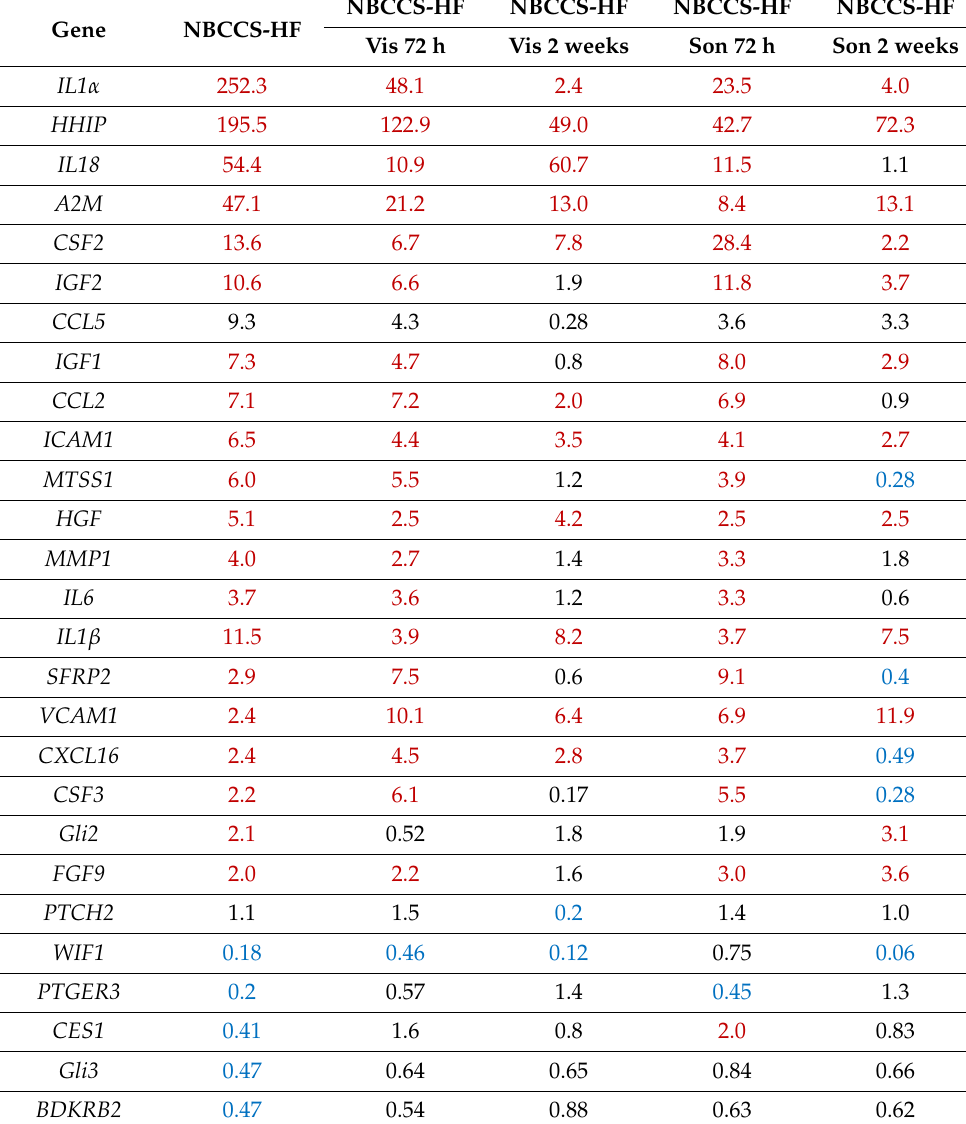
Table 4. Gene expression analysis, 2